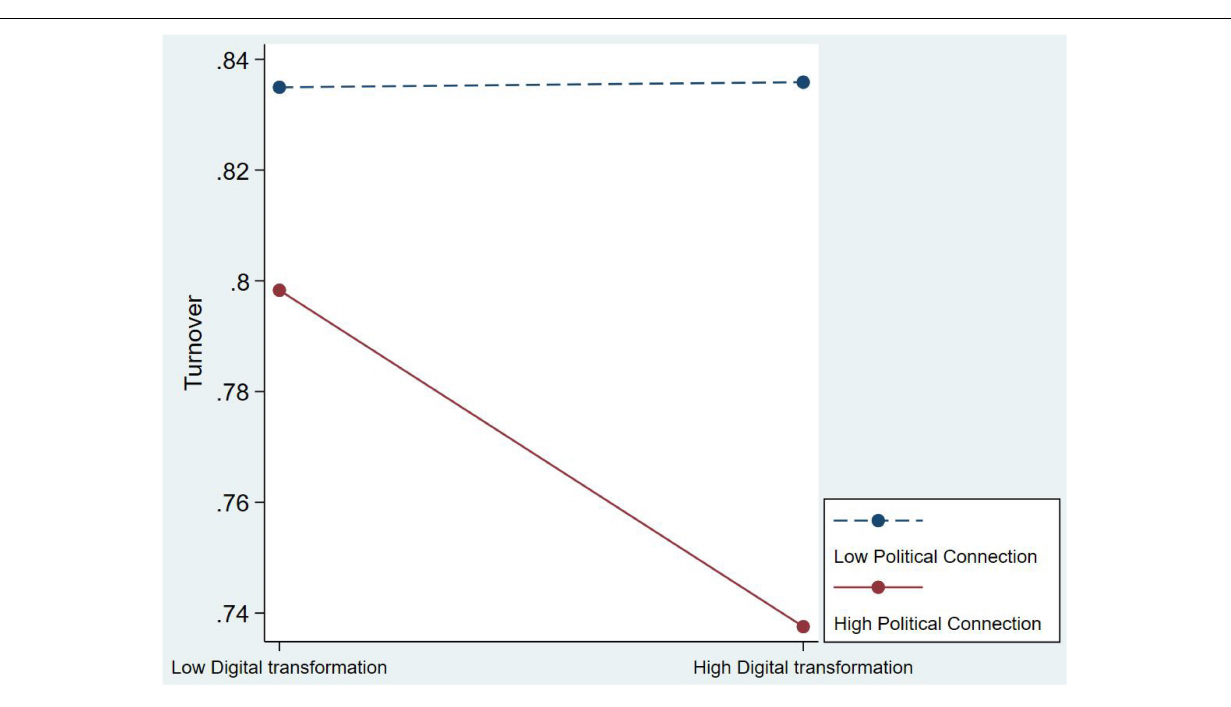
FIGURE 3 | The moderating effect of political connection on digital transformation for Chairman and CEO’